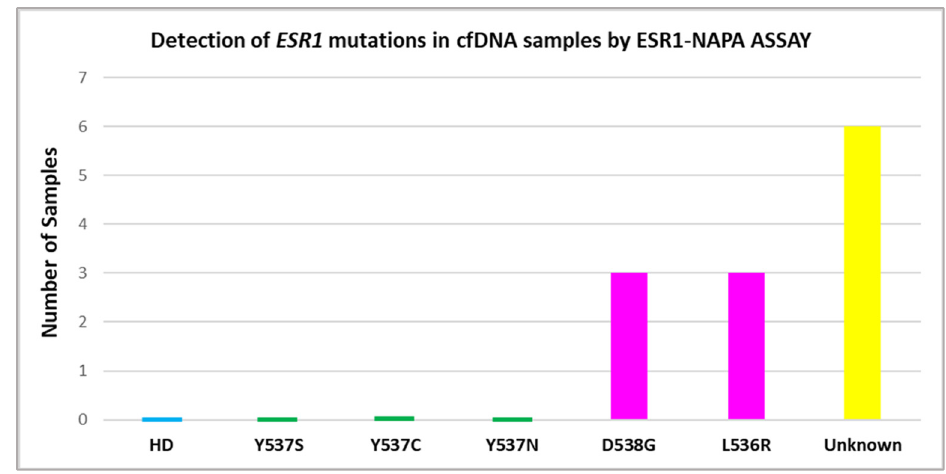
Figure 4. Detection of ESR1 mutations in plasma-cfDNA samples using the NAPA-ESR1 assay.